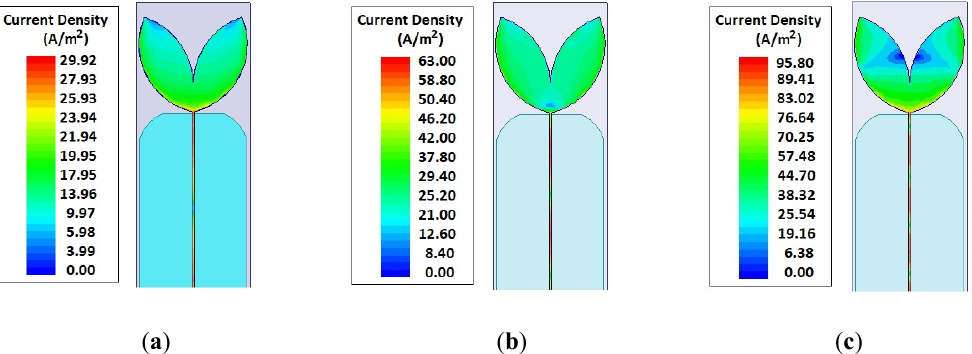
Figure 13. PMA bio-inspired electric current distributions: ( a ) 350 MHz; ( b ) 900 MHz; ( c ) 1500